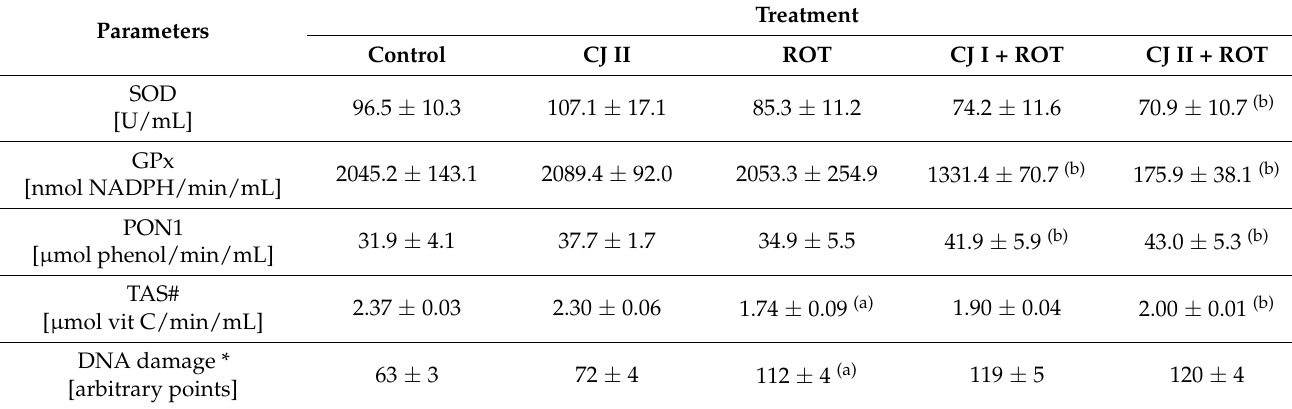
Table 5. Effect of cranberry juice (CJ) on oxidative stress markers in the serum of rotenone (ROT) injected rats. Parameters